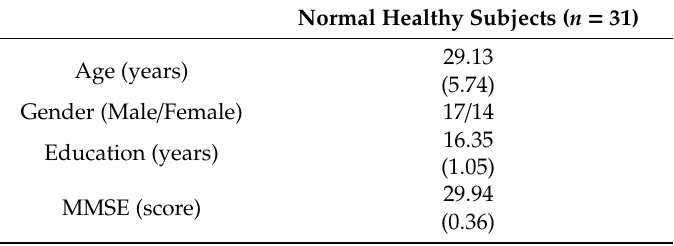
Table 1. Demographic data of the normal healthy